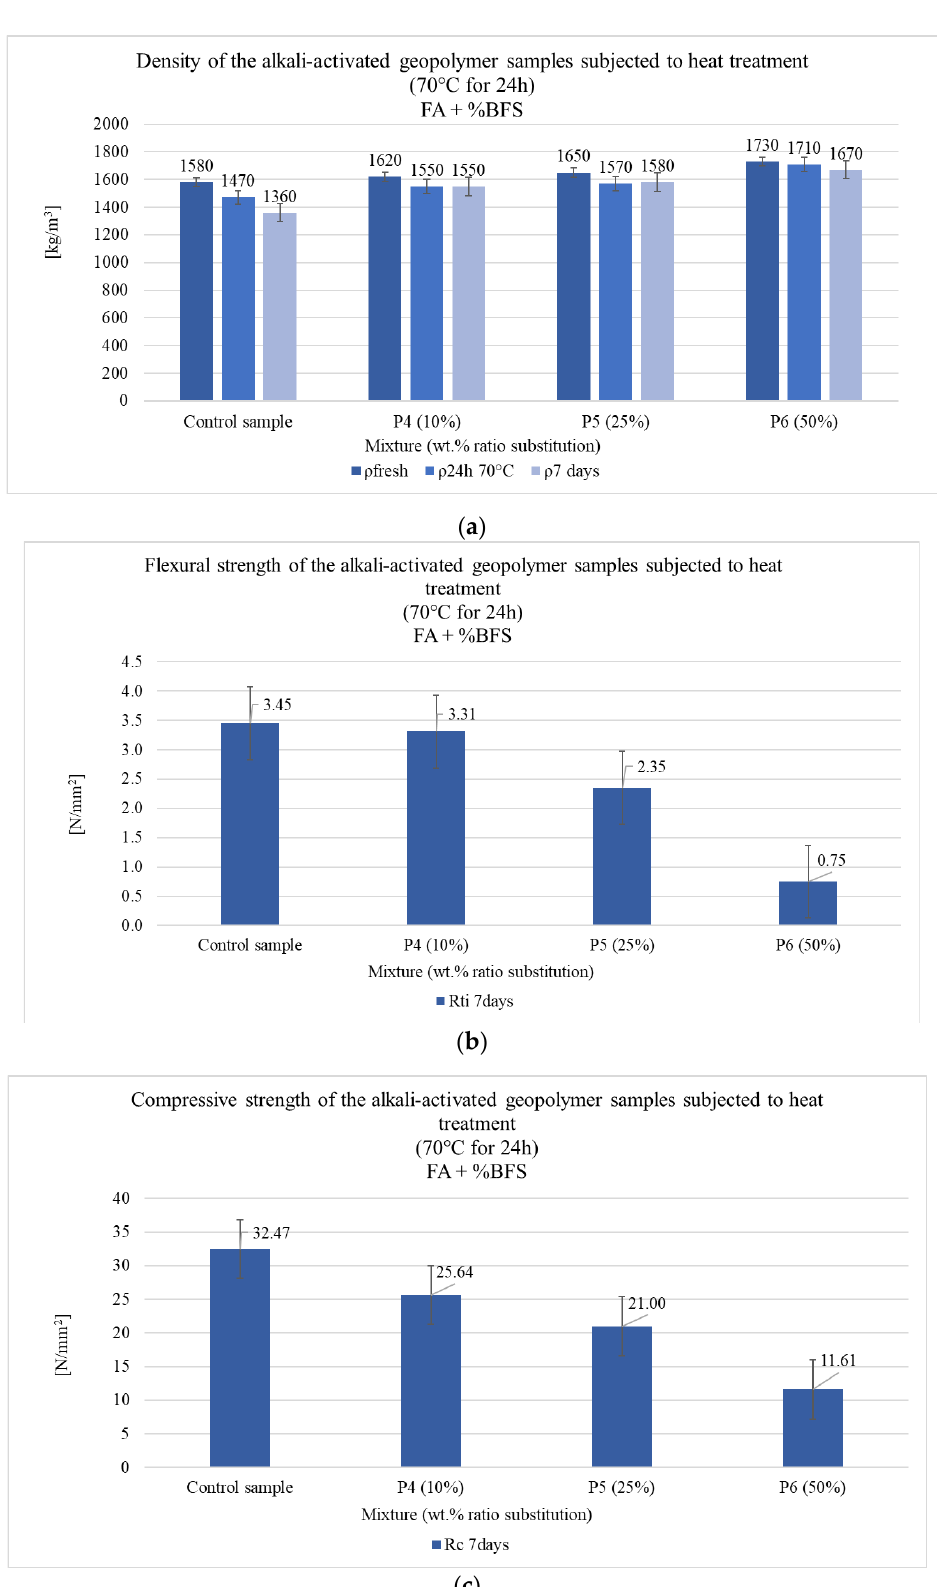
Figure 2. Physico-mechanical performances of the alkali-activated geopolymer binder using BFS as FA substitution subjected to heat treatment: ( a ) Apparent density; ( b ) Flexural strength and ( c ) Compressive strength.